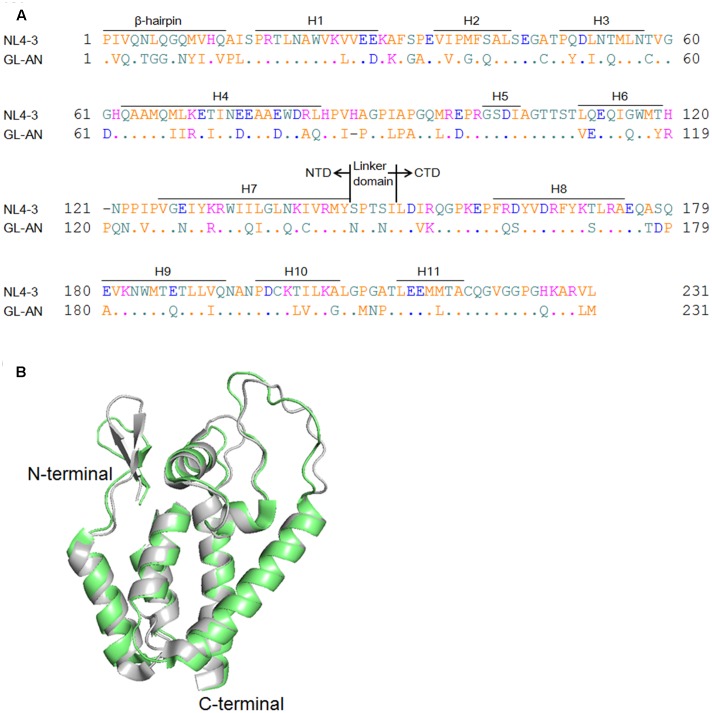
Structural comparison of NL4-3 and GL-AN Gag-CA proteins. (A) Alignment of NL4-3 and GL-AN Gag-CA sequences. CA amino acid sequences of HIV-1 NL4-3 (GenBank accession number: AF324493) and HIV-2 GL-AN (GenBank accession number: M30895) are aligned. The N-terminal domain (NTD), linker domain, C-terminal domain (CTD), β-hairpin, and helices 1 to 11 (H1 to H11) are shown based on previous studies (Gamble et al., 1996; von Schwedler et al., 2003; Robinson et al., 2014; Gres et al., 2015). (B) Superimposition of the NTD structures. Superposed structures of HIV-1 NTD (green, PDB code: 3H4E) and HIV-2 NTD (gray, PDB code: 2WLV) were depicted by PyMOL ver 1.8.